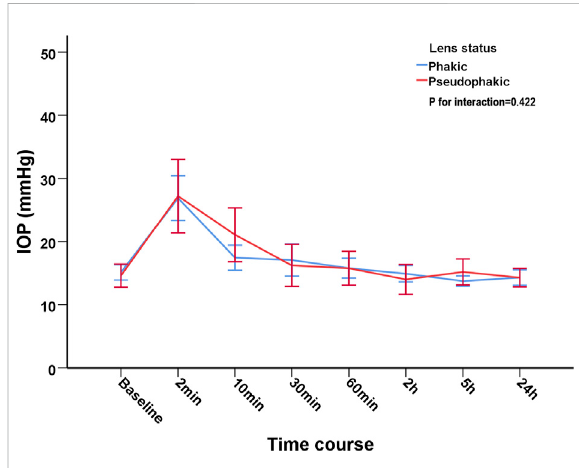
FIGURE 2 The trend of intraocular pressure changes after intravitreal injection of Conbercept in phakic group and pseudophakic